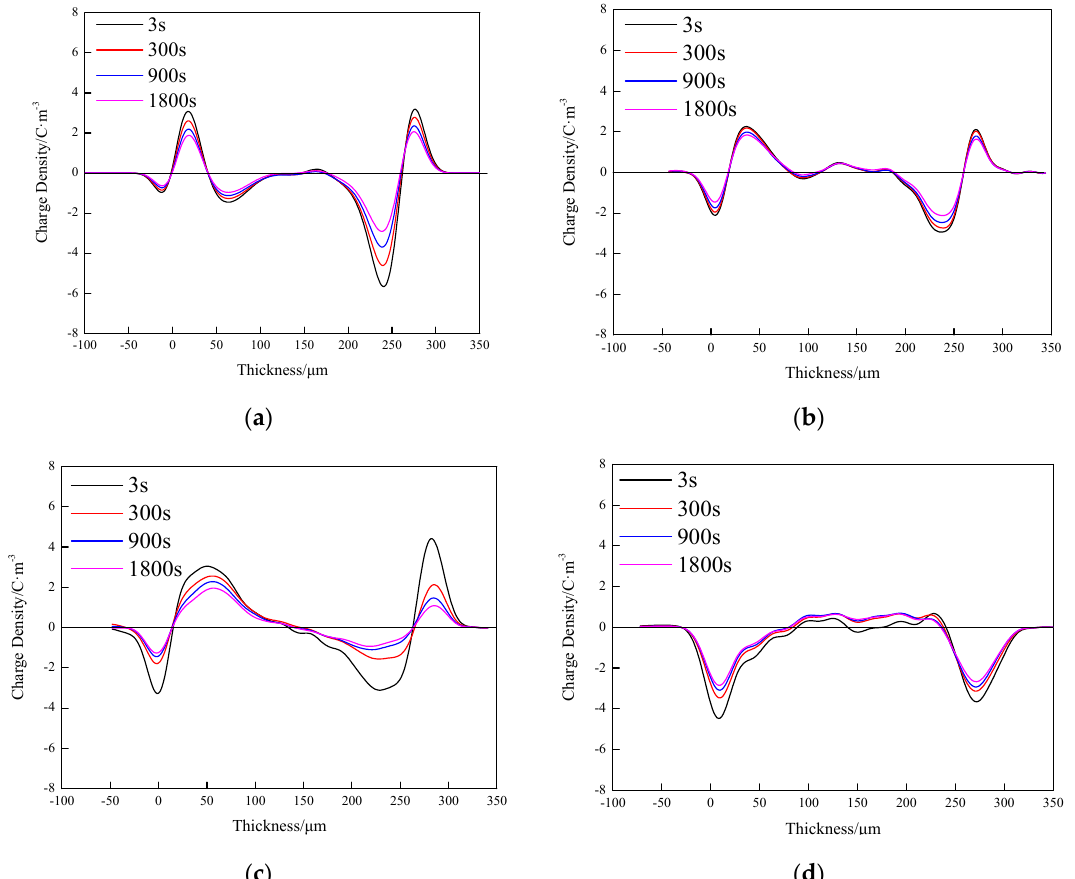
Figure 6. Space charge distributions of neat LDPE and ZnO/LDPE composites in short connection: ( a ) LDPE, ( b ) N3, ( c ) M3, and ( d ) N2M1.